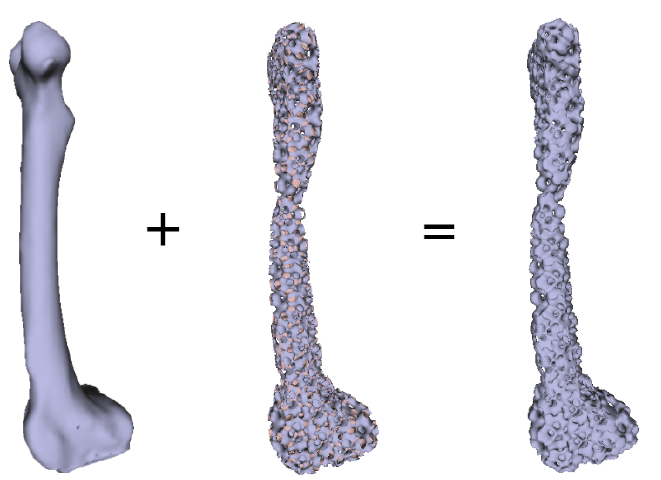
Figure 16. Intersection of the original femur volume with the generated porous volume producing a porous femur